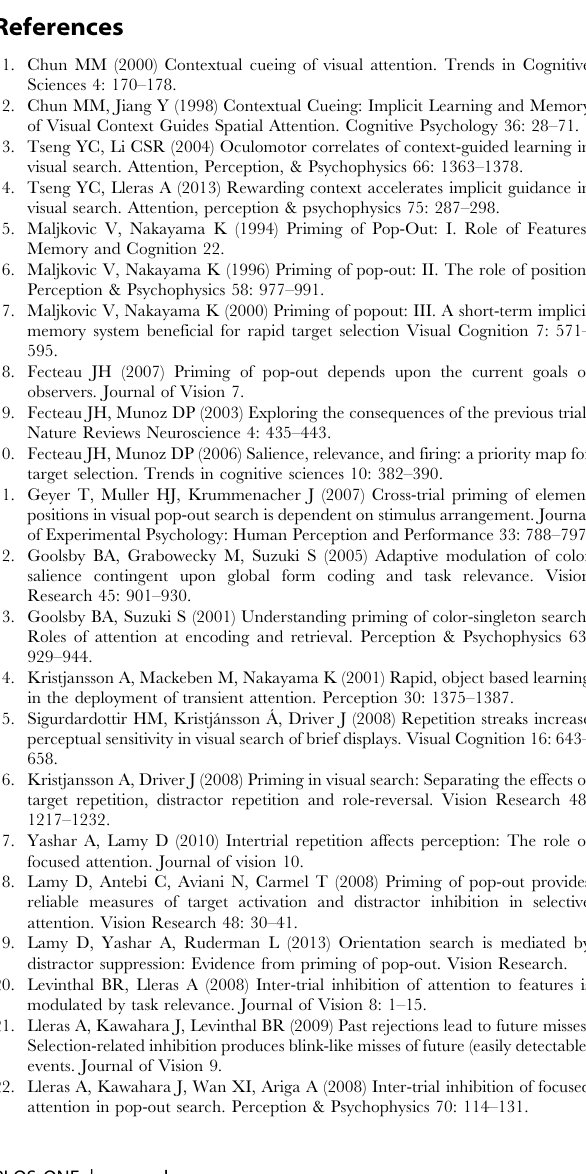
Table S1 Best-Fit Parameters of Expanded Model. Table S2 Best-Fit Parameters of Optimal